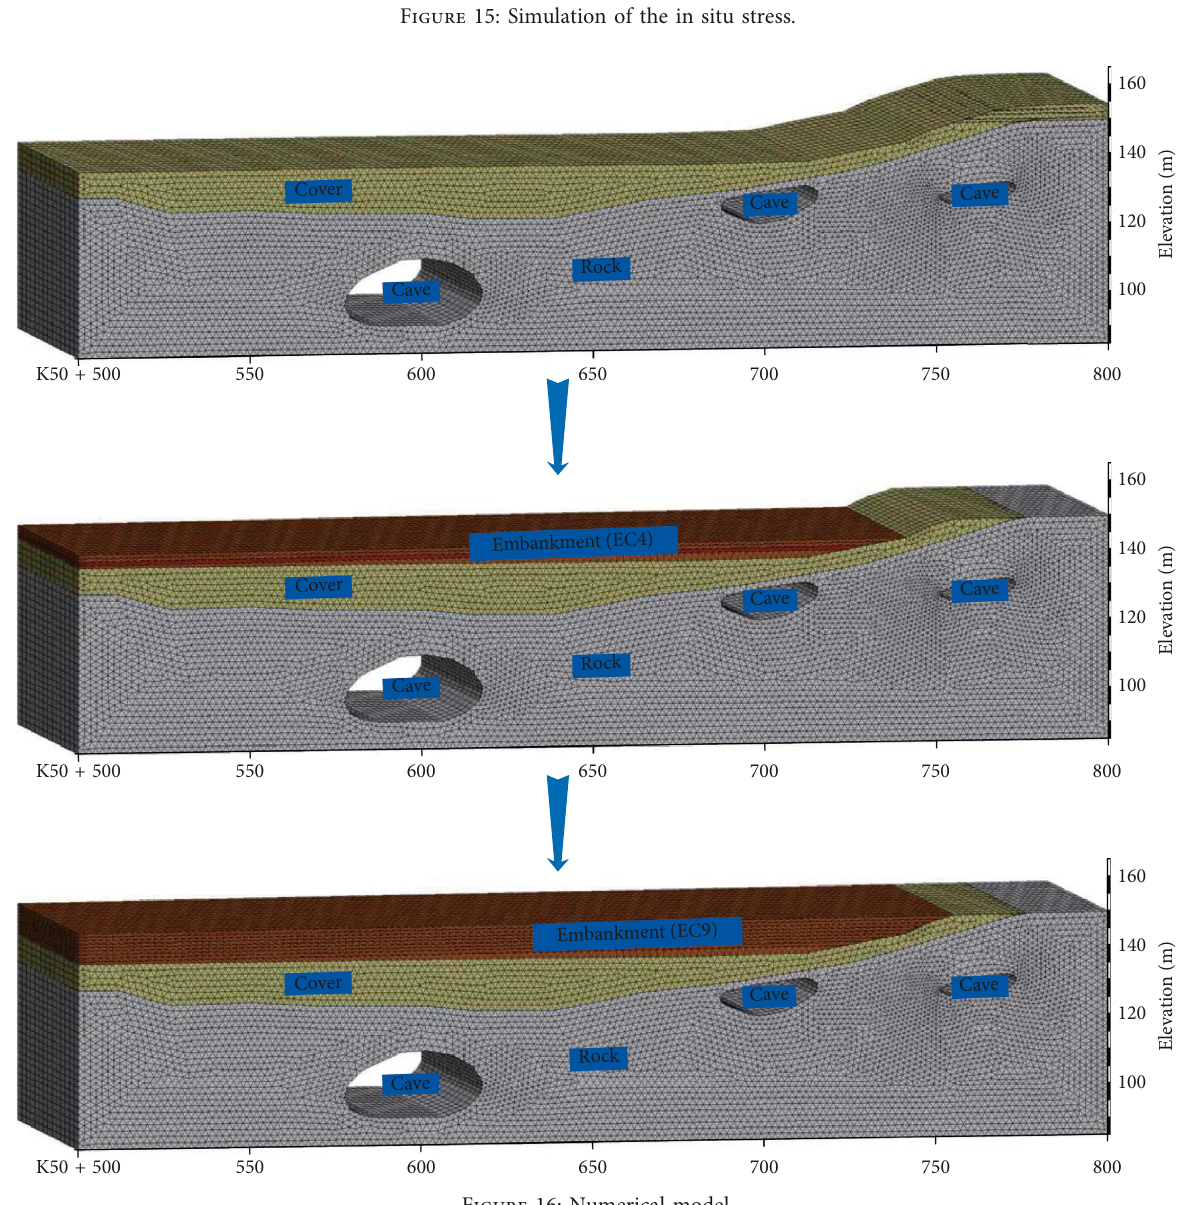
Figure 16: Numerical